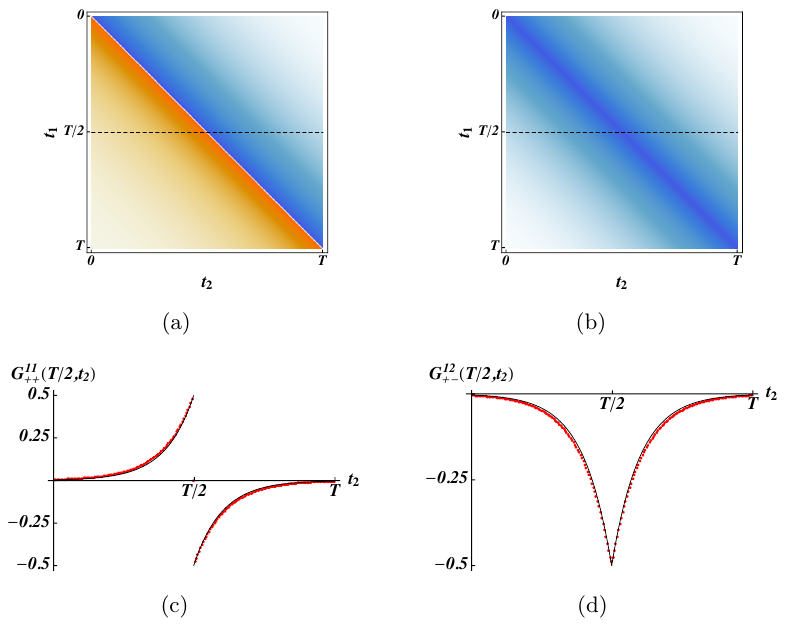
Figure 5 . The replica diagonal (a,c) and replica non-diagonal (b,d) solution of the Schwinger- Dyson equation for n = 2 R(cid:19)enyi entropy. We plot G 11 ( t 1 ; t 2 ) and G 12 ( t 1 ; t 2 ) for replica diagonal ++ + (cid:0) and non-diagonal solutions, respectively. (c,d) are the values of Green’s function on the dashed line in (a,b). The red dot (black line) represents the numerical (analytic) solution. We choose the parameter q = 4 ; J = V = 1 ; J T = 20. The number of discretization is M = 400.